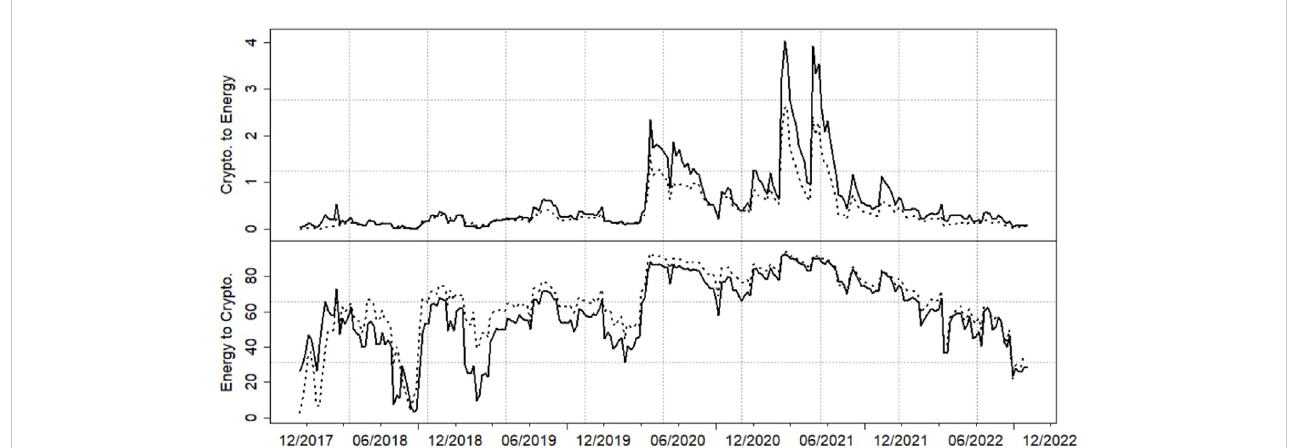
FIGURE 12 Comparison between directional volatility connectedness of baseline estimation and estimation with a smaller sample. The solid line is the volatility connectedness between cryptocurrencies and energy based on the smaller samples and the dotted line is the directional volatility connectedness between cryptocurrencies and energy in a baseline